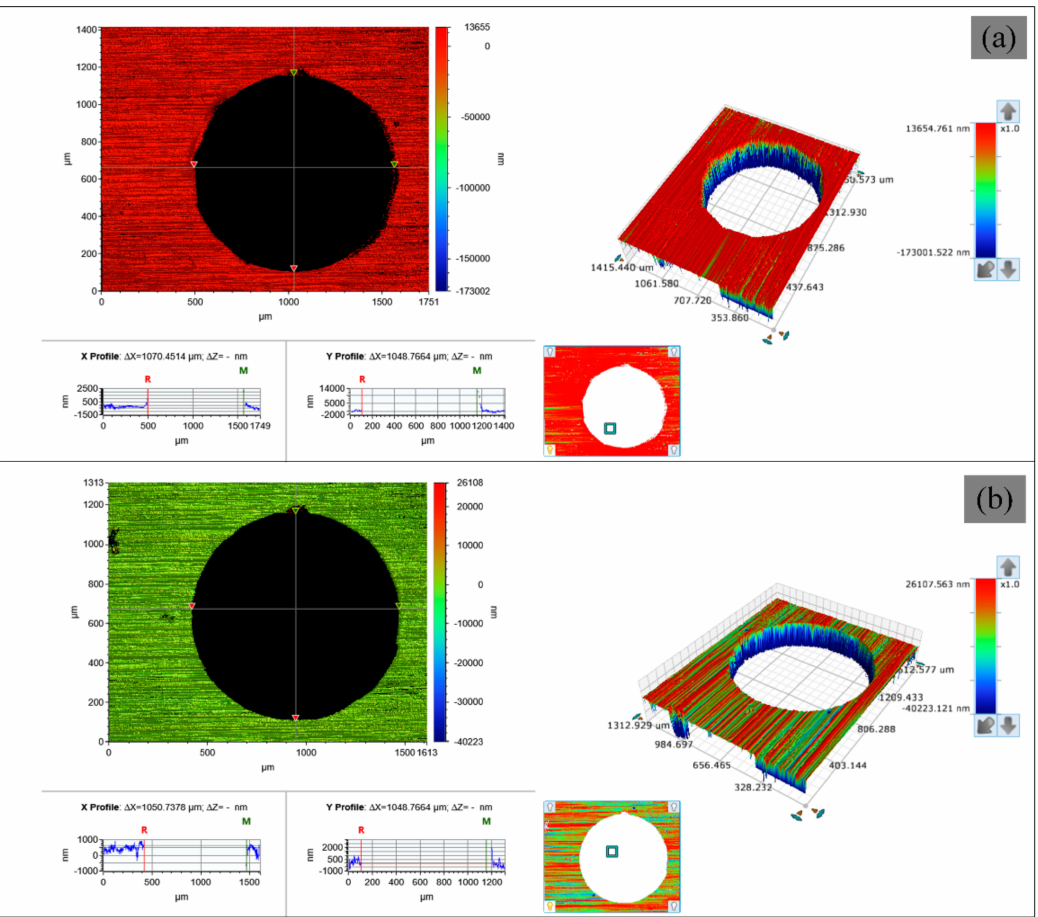
Figure 11. Surface morphology of 6061 aluminum alloy drilled by WJGL at different speeds under the same laser power in accordance with helical drilling method: ( a ) 0.8 mm/s, ( b ) 1.2 mm/s.